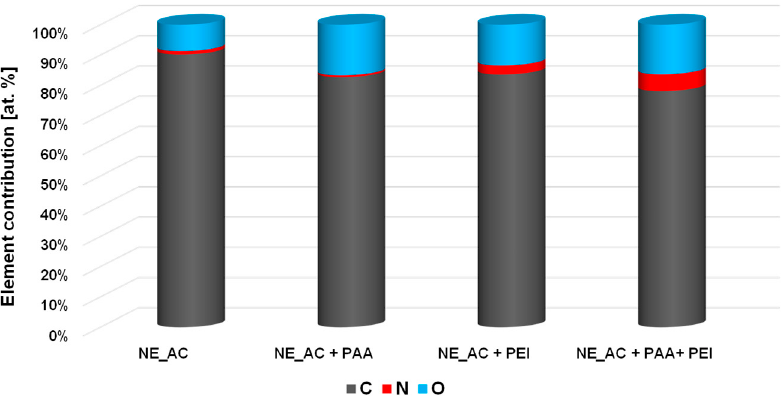
Figure 8. Elemental composition of the activated carbon’s surface before and after adsorption of polymers at 25 °C [at. %].